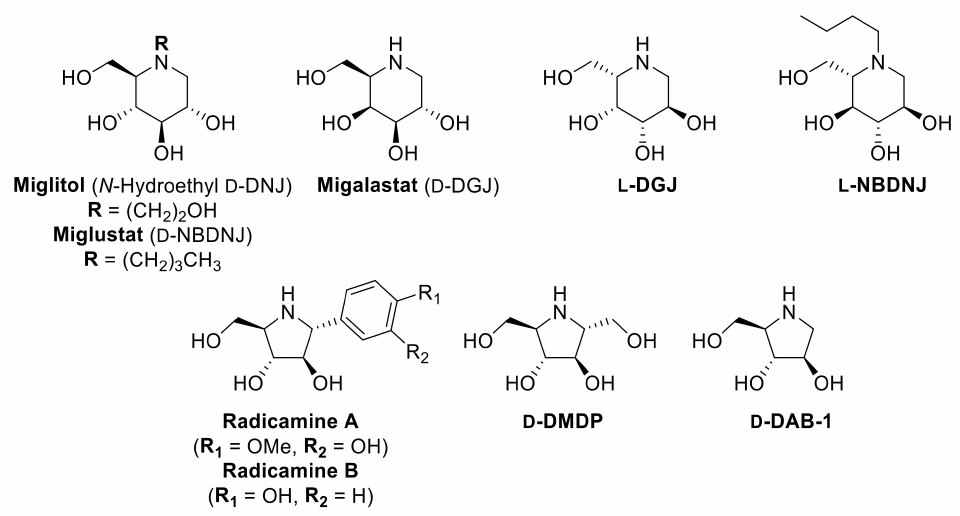
Figure 1. Pyrrolidine and piperidine iminosugars.